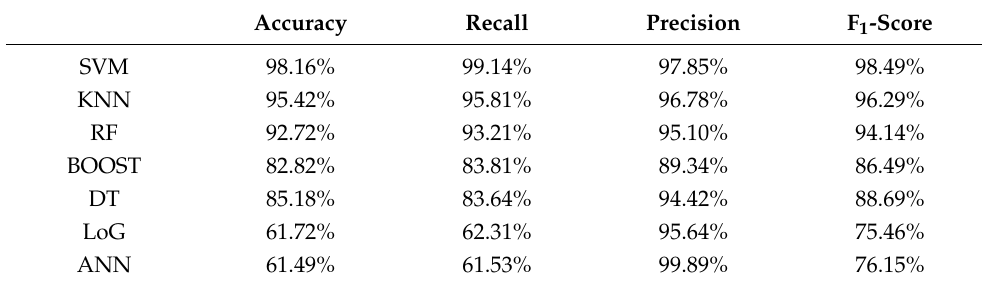
Figure 8. Accuracy of seven classifier models. Table 4. Performance evaluation of seven classifier models.